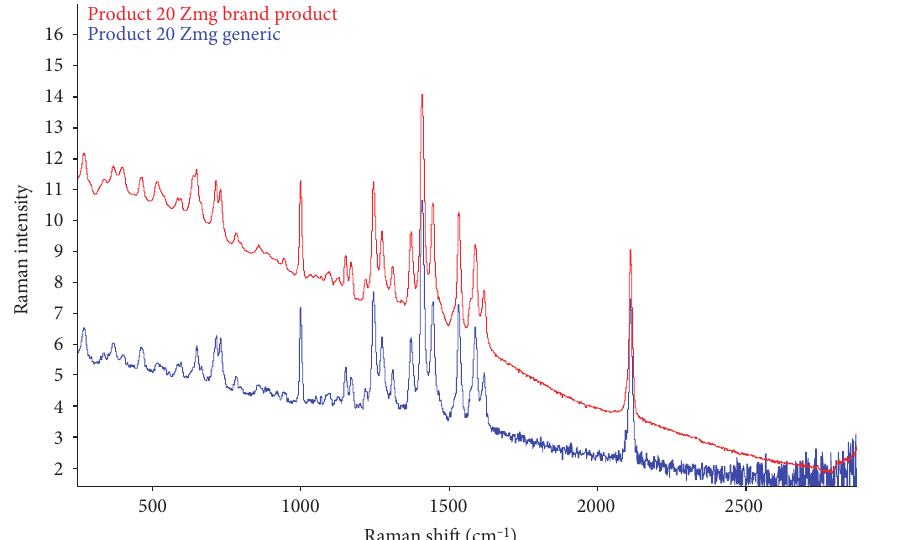
Figure 4: Raman spectra of a brand product and one of its generic (product 20 Zmg). Both samples present a similar formulation and the same dosage, and thus similar Raman spectra.